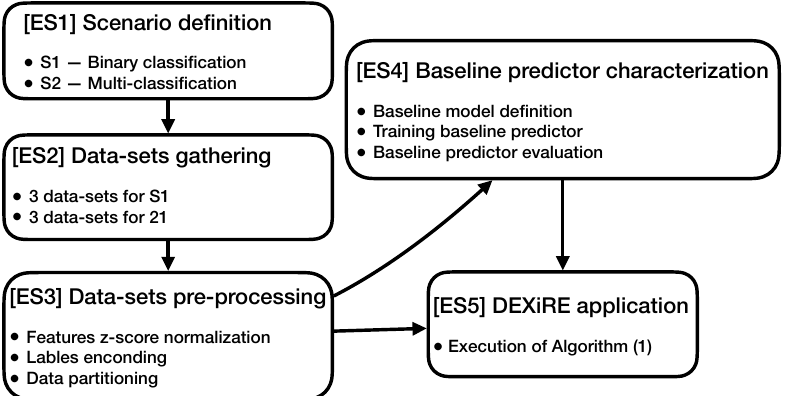
Figure 7. Experimental setup workflow describes the experimental steps (ES) carried out to test the DEXiRE